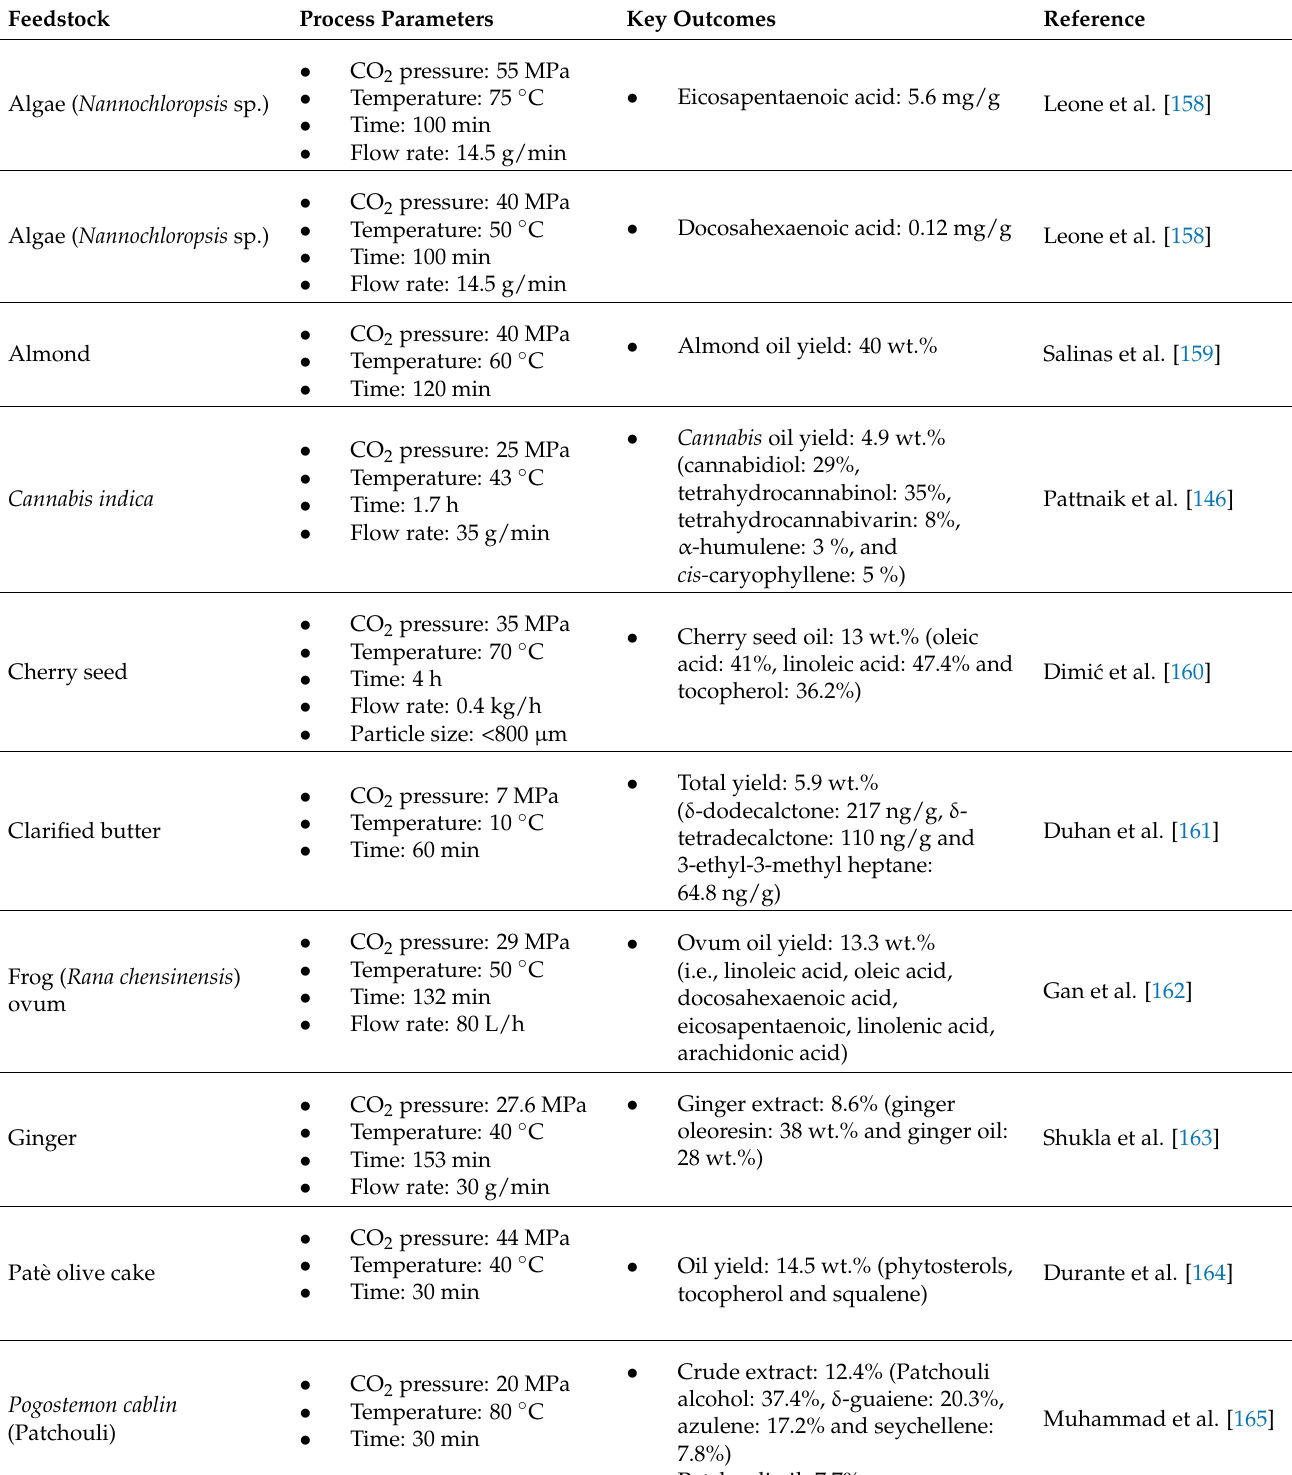
Table 3. Summary of notable studies on the extraction of natural products using SCCO 2 . Feedstock Process Parameters Key Outcomes